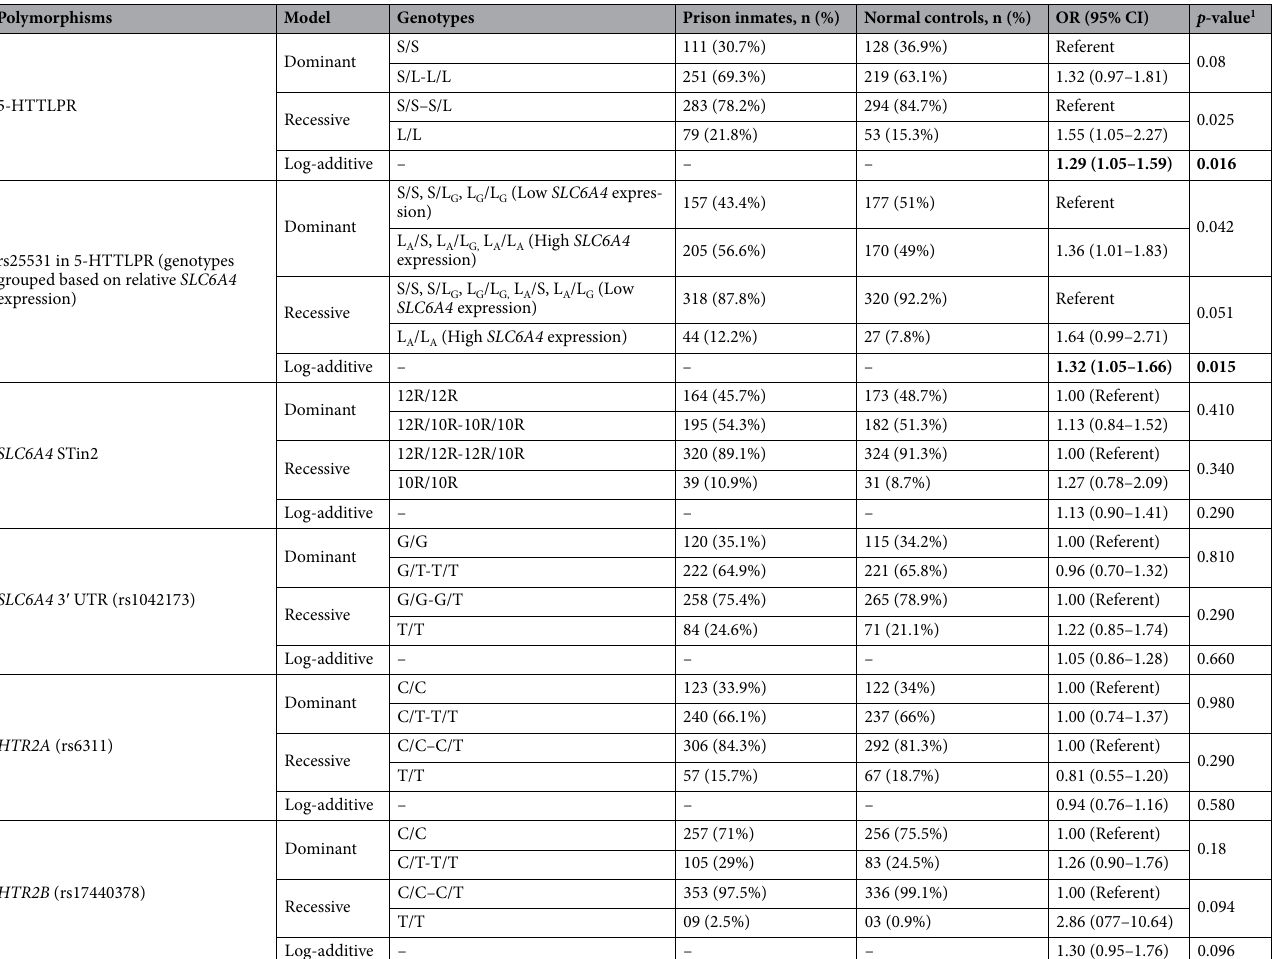
Table 2. Association of the studied polymorphisms in serotonergic system genes with criminal delinquency assuming different genetic models. OR, odds ratio; CI, confidence interval; n (%), frequency. 1